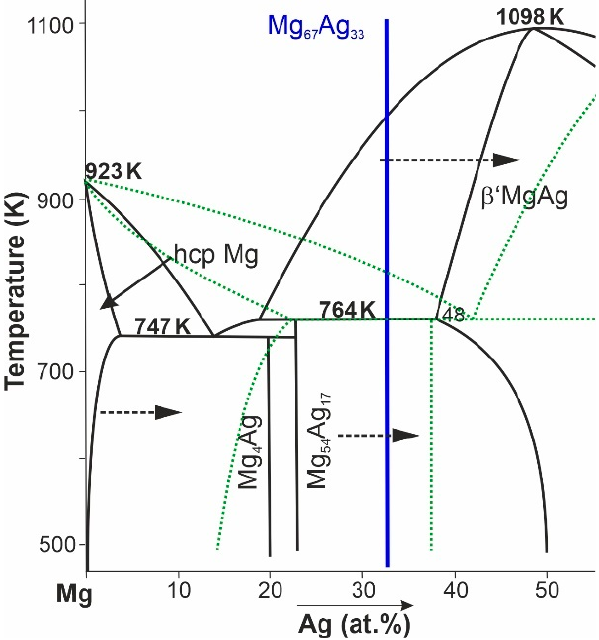
Figure 2. Schematic illustration of shifting phase boundaries during the solidification of Mg 67 Ag 33 (blue line) at about 50 K/s superposed on a segment of the binary Mg–Ag equilibrium phase diagram. The shifted phase boundaries characterize the non-equilibrium solidification, and they are depicted as dashed green lines. The equilibrium phase diagram was created on data reported in [39].